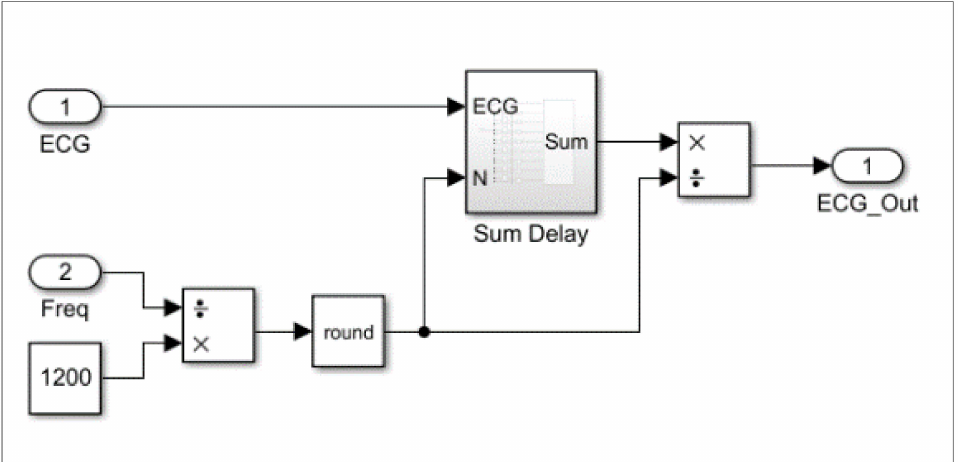
Figure 11. Adaptive MAV block diagram (Simulink).